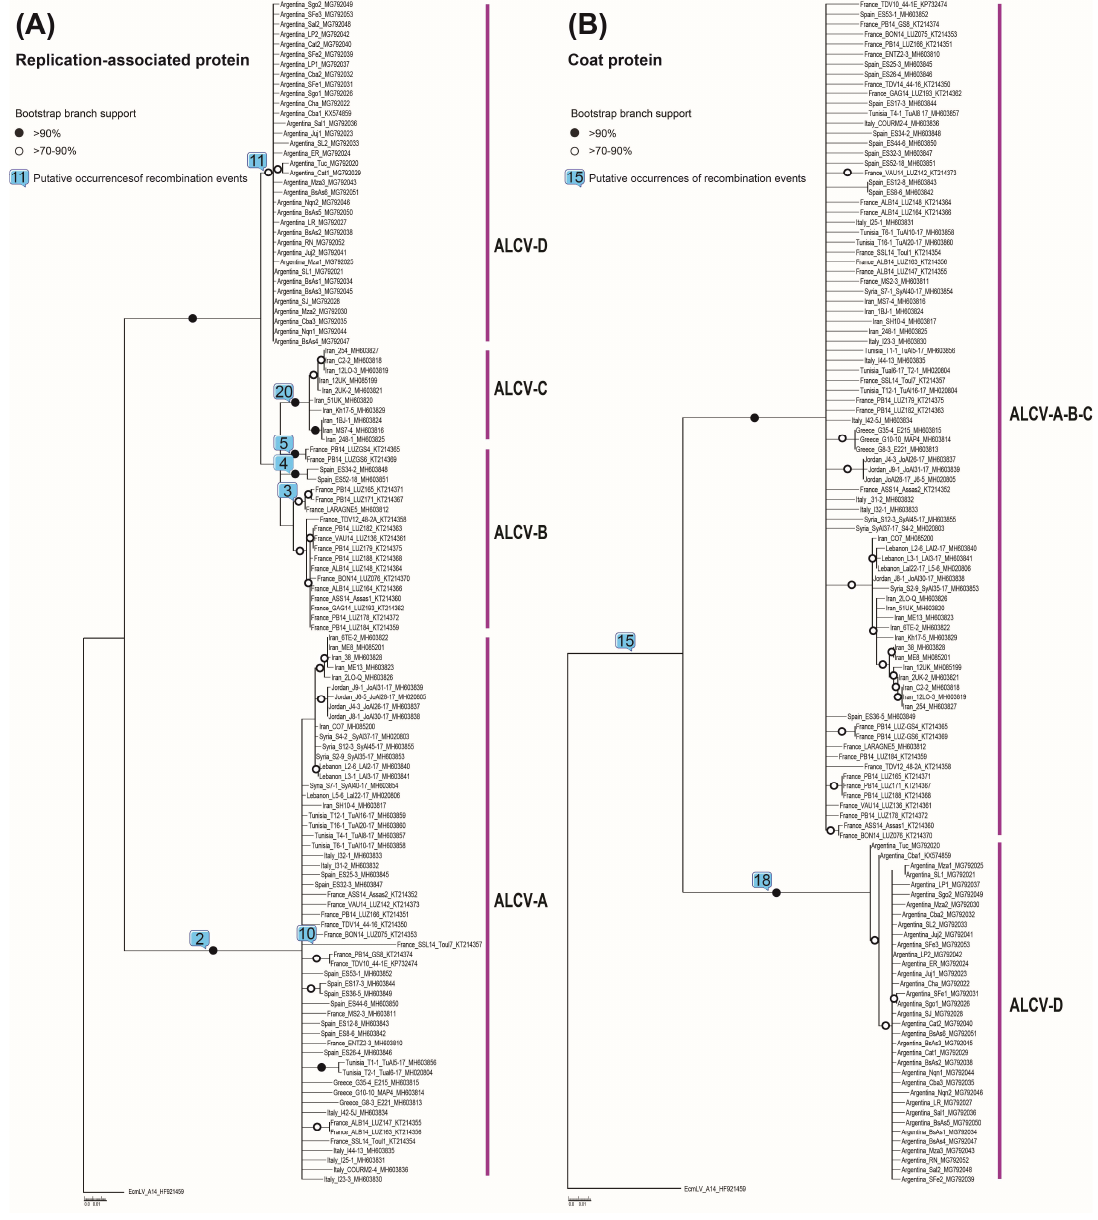
Figure 2. Maximum-likelihood phylogenetic trees of predicted replication-associated protein (Rep) ( A ) and coat protein (CP) ( B ) amino acid sequences of 120 ALCV isolates, both rooted with Euphorbia caput-medusae latent virus CP and Rep amino acid sequences. Branches with less than 50% bootstrap support were collapsed. Branches associated with a black dot have bootstrap supports above 90% whereas those with white dots have bootstrap supports above 70%. Putative occurrences of recombination events (numbers within squares correspond to the number of the event as listed in Table 2) are depicted on branches of both phylogenetic trees.